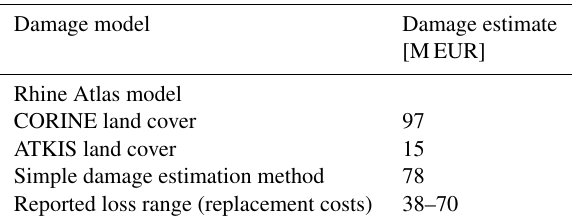
Table 5. Comparison of loss estimates with the reported loss range for the flood event of June 2013 in